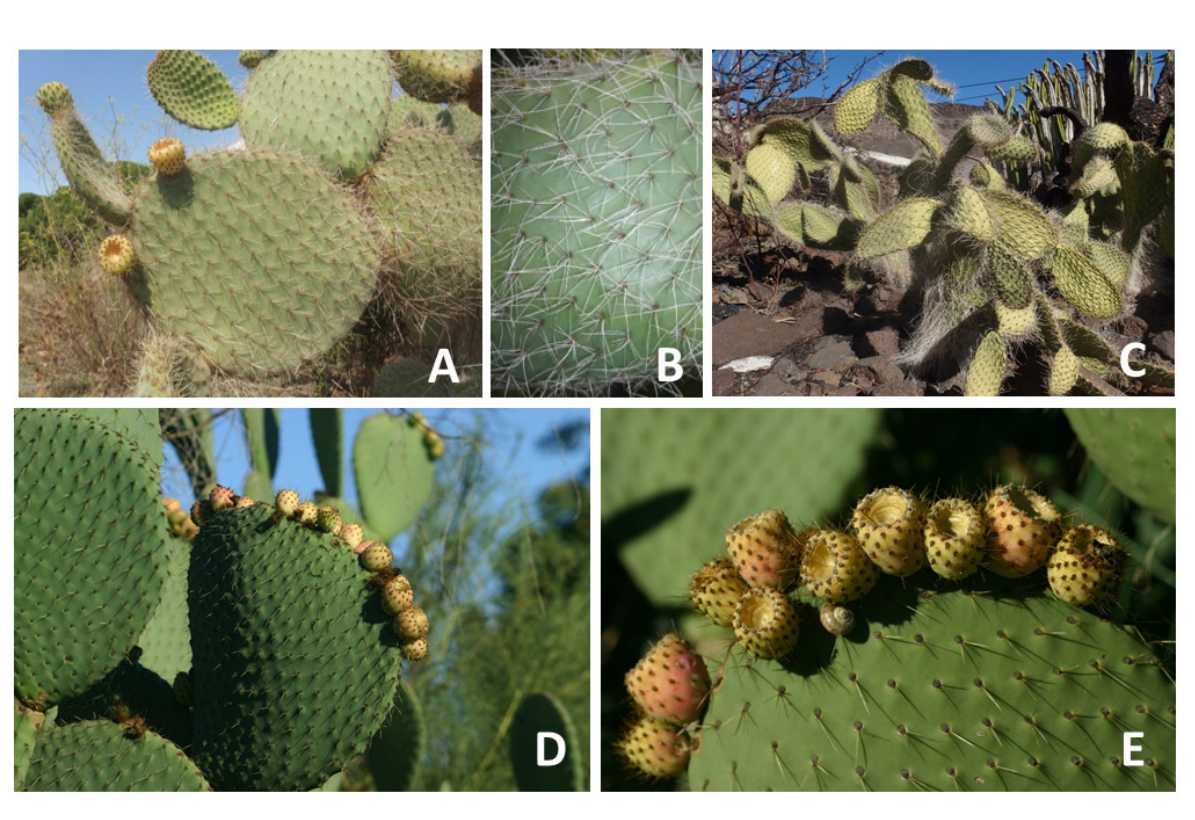
Figure 2. A-C) Opuntia leucotricha . D-E) O. spinulifera . Ayamonte, November 2018, E. Sánchez